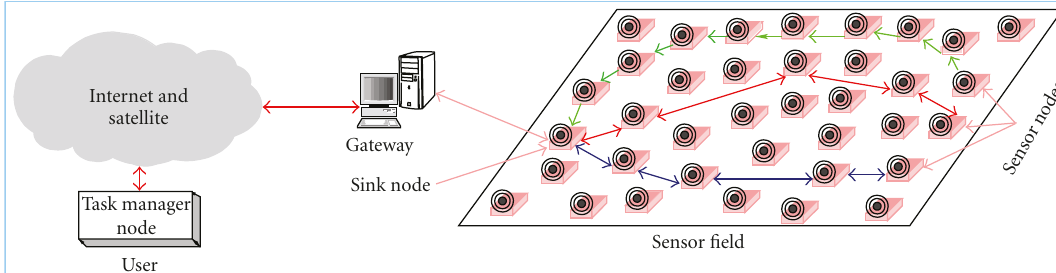
Figure 1: Sensor nodes scattered in a sensor